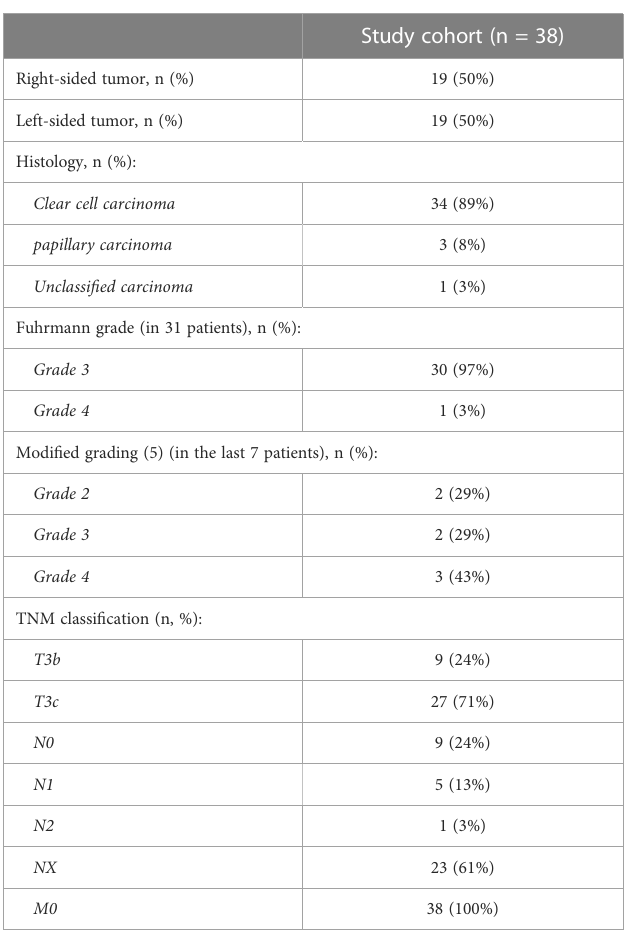
TABLE 2 Histopathologic tumor characteristics.